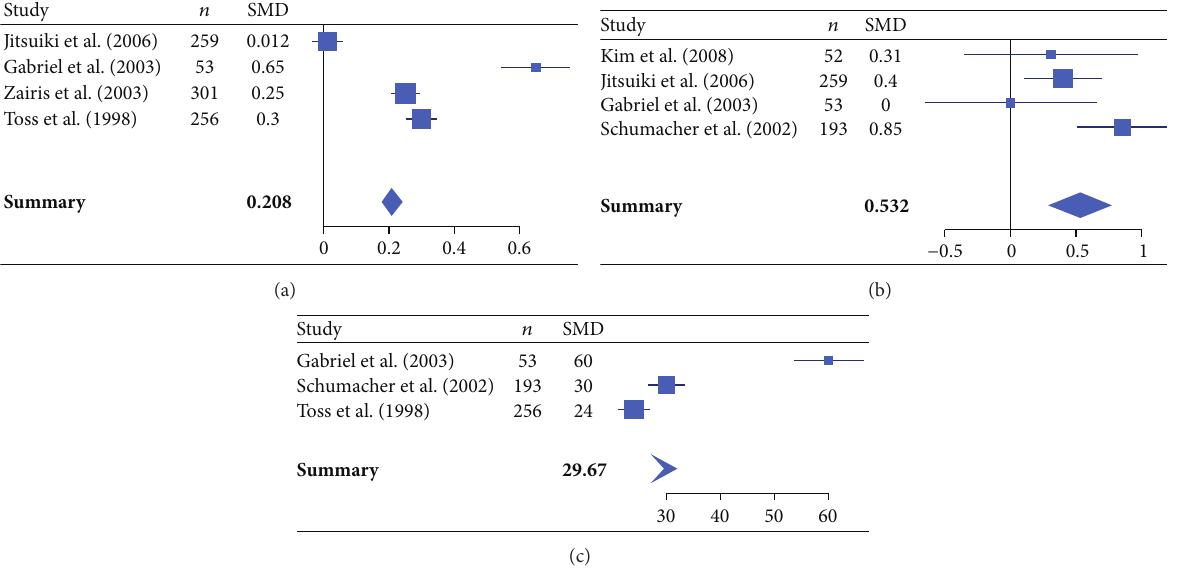
Figure 3: Forest plot of standardized mean differences (SMDs) of individual studies and pooled SMDs for hsCRP (a), IL-6 (b), and fibrinogen (c) in C. pneumoniae IgA seropositive and seronegative patients with atherosclerotic cardiovascular